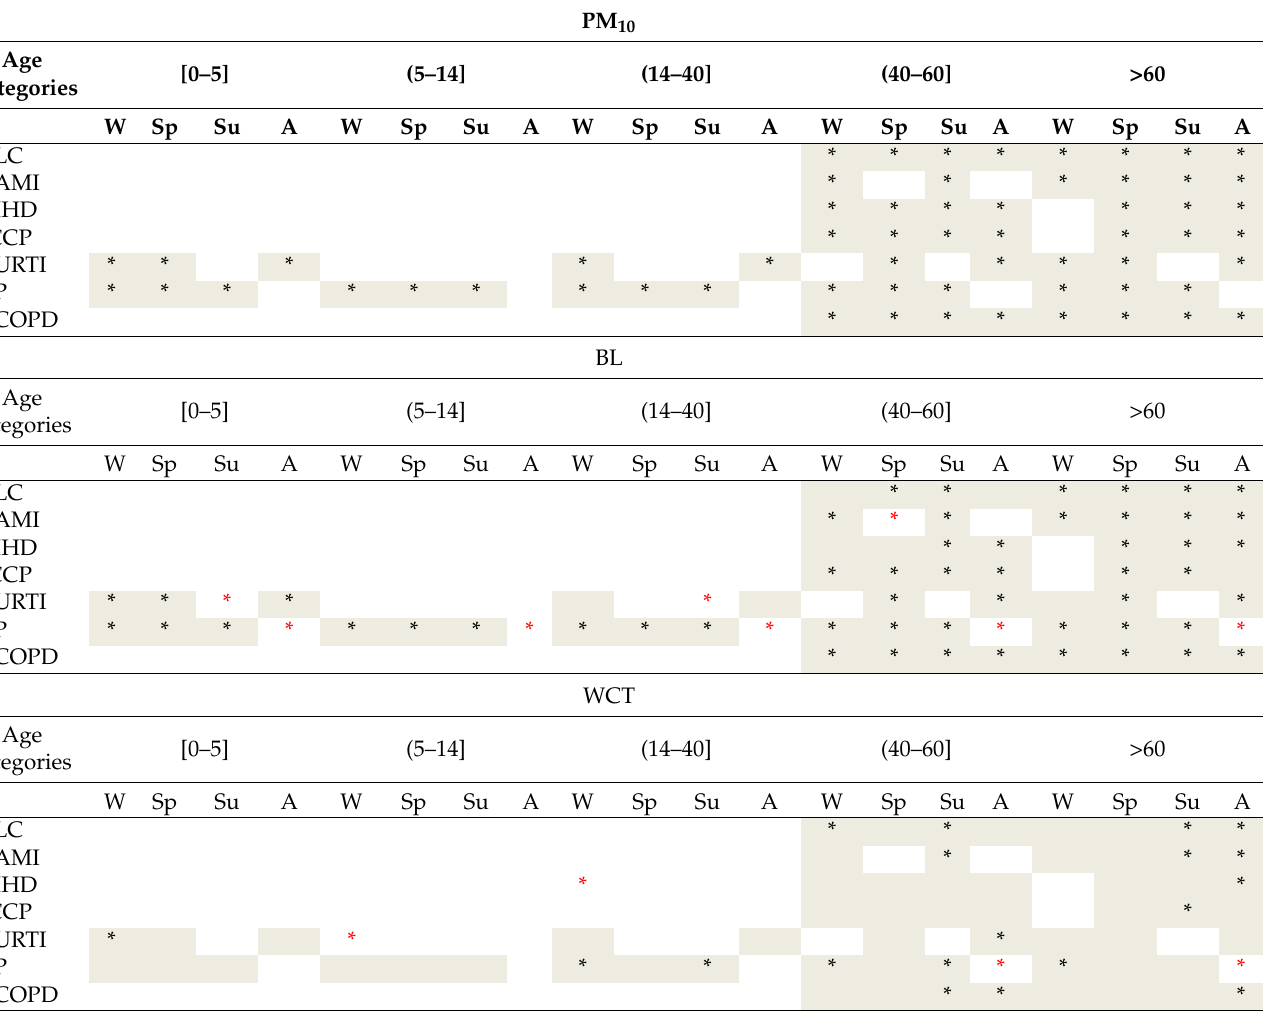
Table 2. Significant Pearson correlation coefficients between PM 10 , climatological data, and disease occurrence after the Fourier